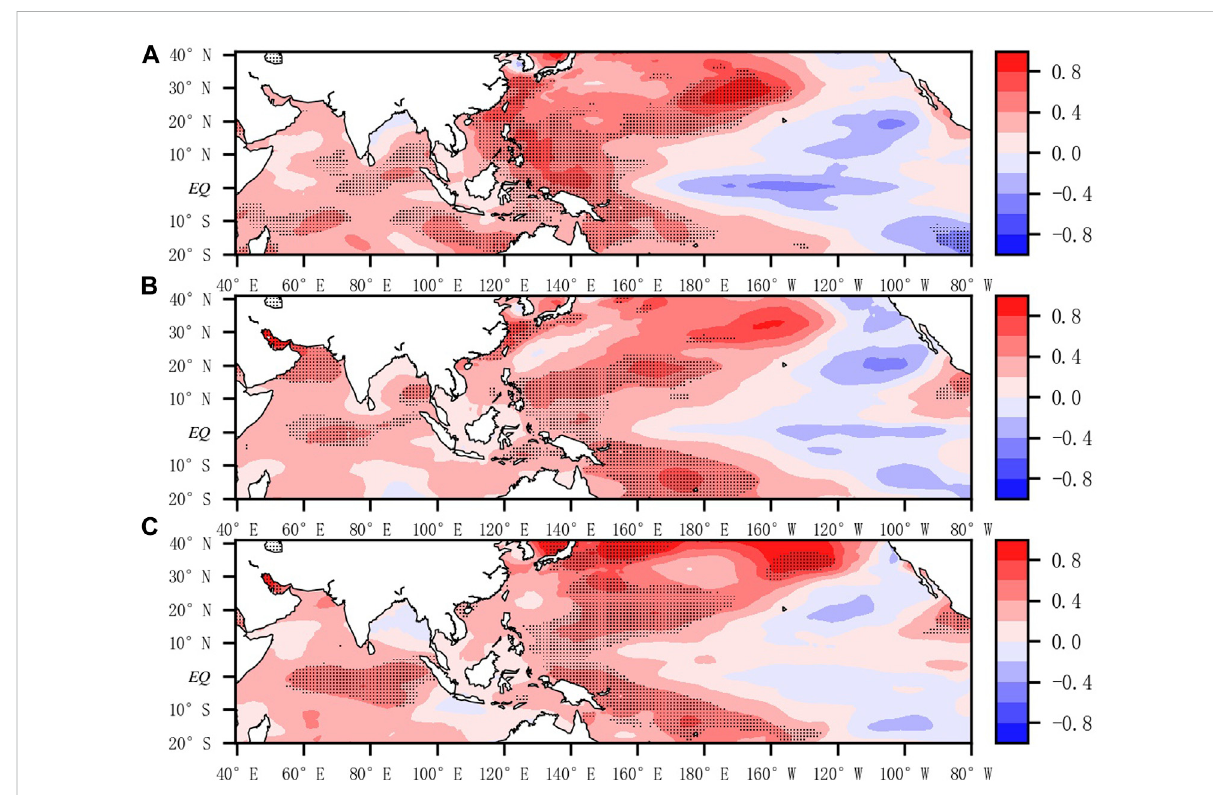
FIGURE 9 Interdecadal differences in SST between P1 and P2 periods (P2-P1): winter (A) ; spring (B) ; summer (C) . Dotted areas indicate values exceeding the 95% con fi dence level by t